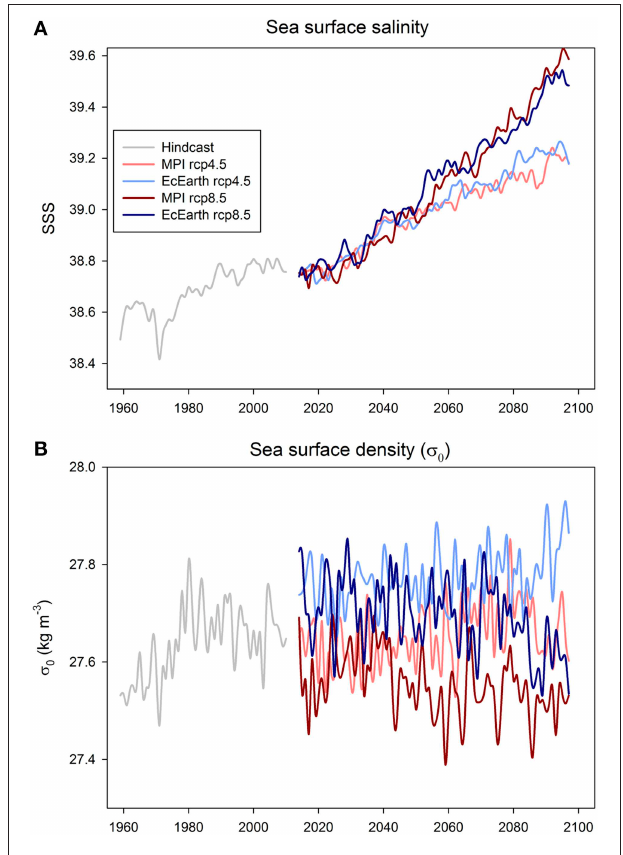
FIGURE 6 | Time series of mean (basin averaged) (A) sea surface salinity (SSS) and (B) surface density ( σ 0 ) for the hindcast (gray line) and the different simulation scenarios (color